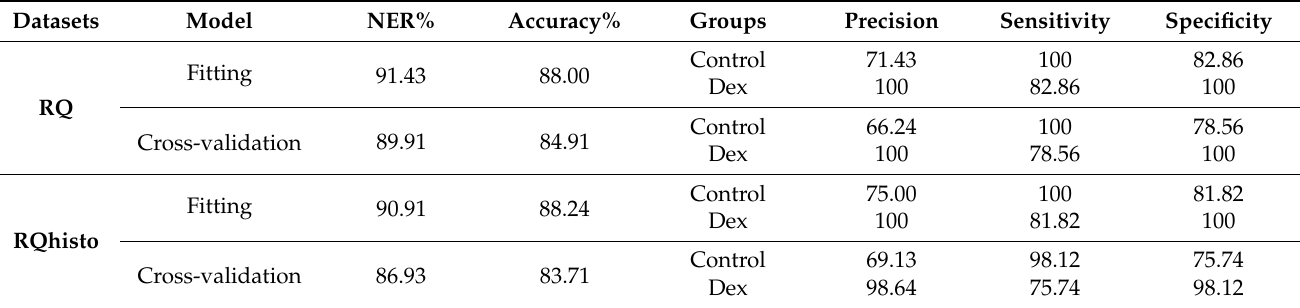
Table 3. Classification performances in fitting and cross-validation for PLS-DA applied to the RQ dataset (a) and to the RQhisto dataset (b), reporting Non-Error-Rate % (NER), Accuracy %, Sensitivity, Specificity and Precision.